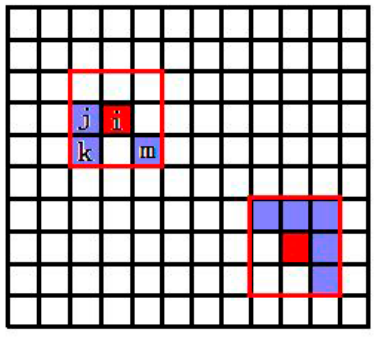
Figure 2. The schematic for space consistency of hyperspectral image.